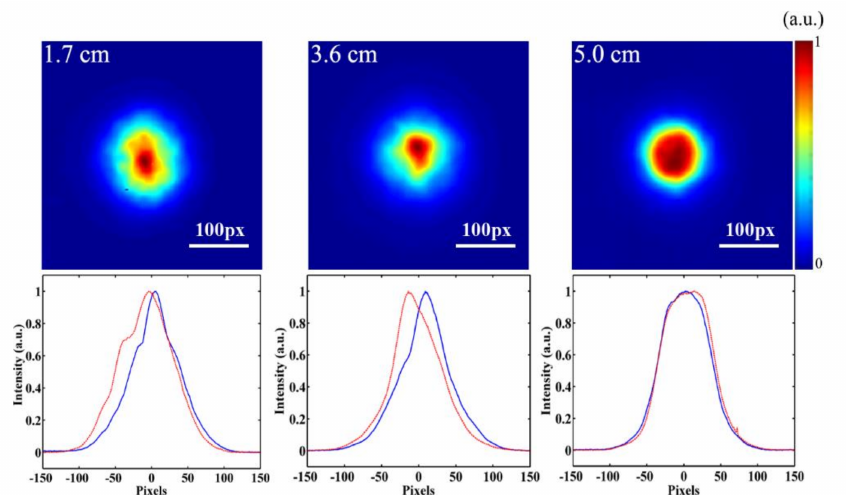
Figure 7. The beam profiles and the corresponding intensity profiles in the two orthogonal directions (red line: vertical; blue line: horizontal) from the MMFs with different bi-tapered lengths at the input peak power of 507.9 kW (scalebar: 100 pixels).